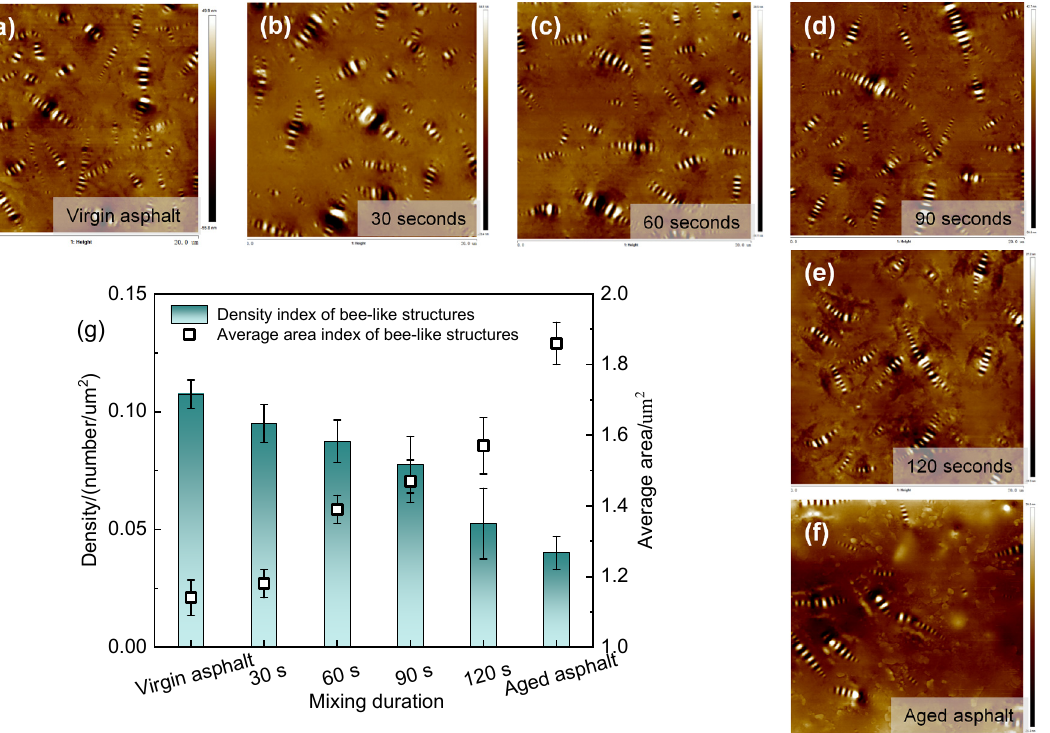
Figure 15. AFM image test and analysis results: ( a ) virgin asphalt binder; ( b ) blended asphalt binder under the 30 s mixing duration; ( c ) blended asphalt binder under the 60 s mixing duration; ( d ) blended asphalt binder under the 90 s mixing duration; ( e ) blended asphalt binder under the 90 s mixing duration; ( f ) aged asphalt binder; ( g ) Variation of density and average area of bee-like structures of blended asphalt with the different mixing